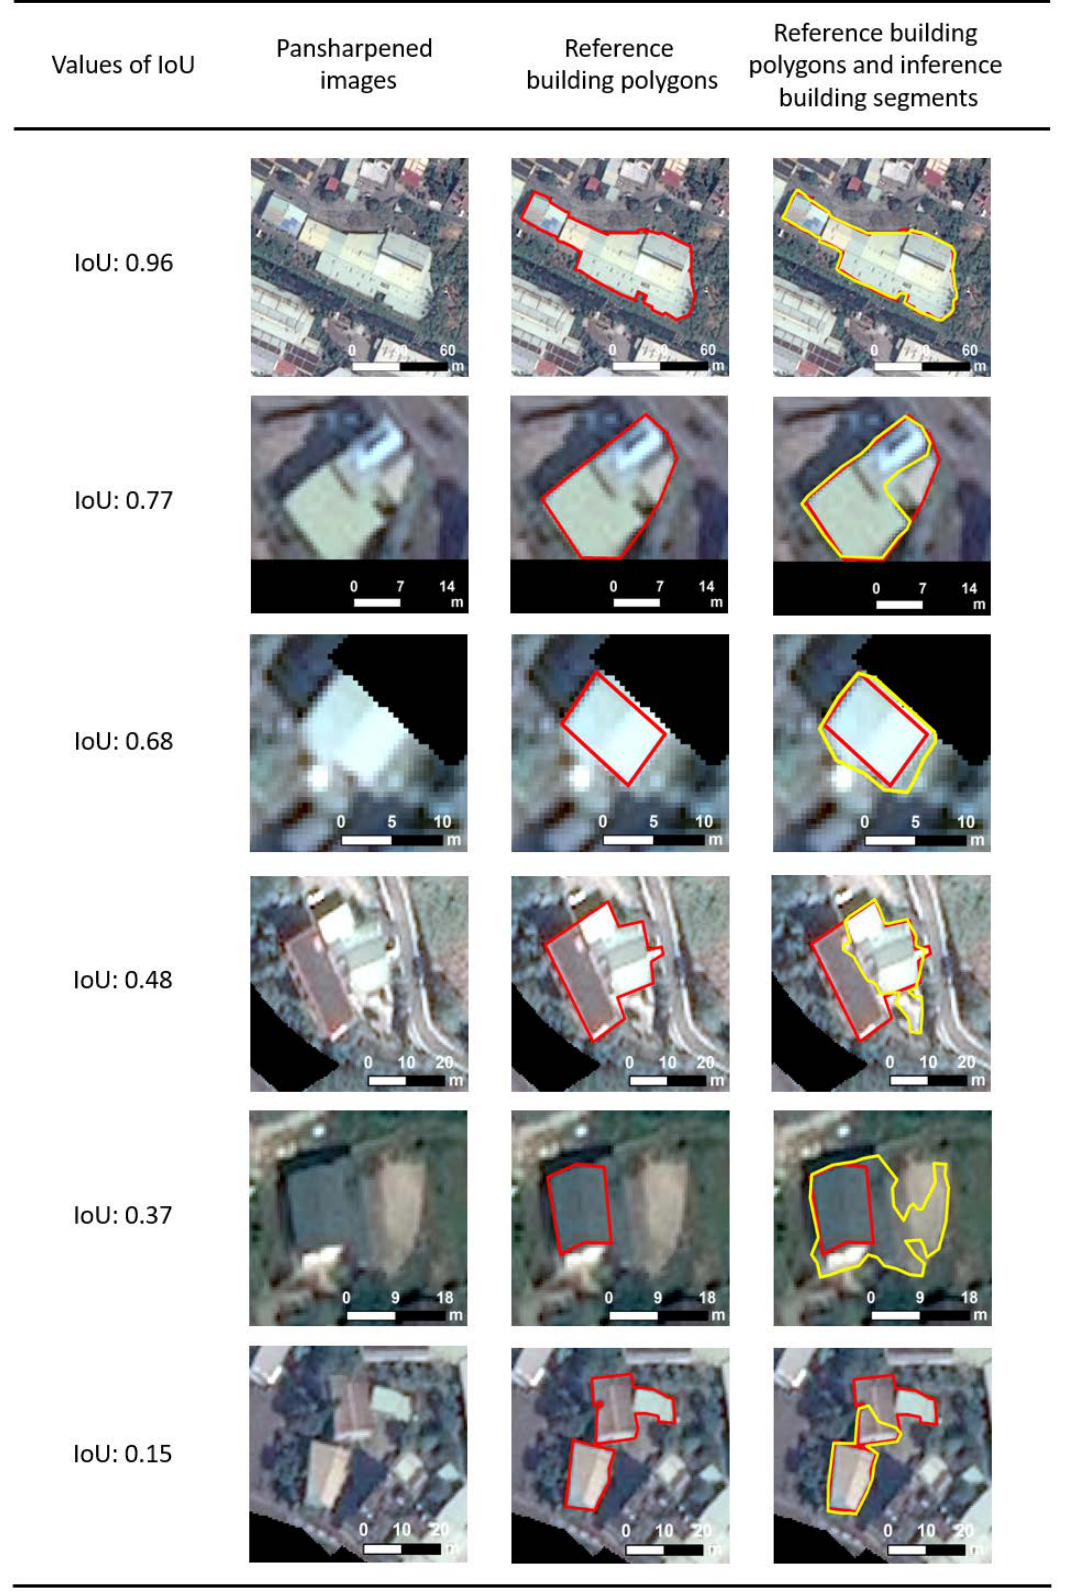
Figure 11. Examples of inference results with various IoUs. Reference building polygons are denoted as red, and inference building segments are denoted as yellow. The first column is values of IoU; the second column is the pansharpened images; the third column is the reference building polygons digitized manually; the last column is the overlay of the reference building polygons and the inference building